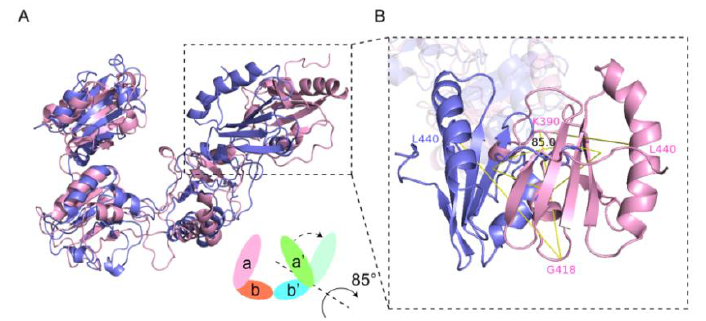
Figure 3. Conformation change of wPDI in its redox cycle. ( A ) the structural superposition of oxidized wheat protein disulfide isomerase (wPDI O ) (pink) and wPDI R (slate). The cartoon representation of the conformational change is below. ( B ) domain rotation of a′ during the redox cycle of wPDI. Taking G418 and K390 as the rotation axis, an 85° rotation takes place where the G418, K390, and L440 plane rotates from wPDI O (light magenta) to wPDI R (tv_blue).